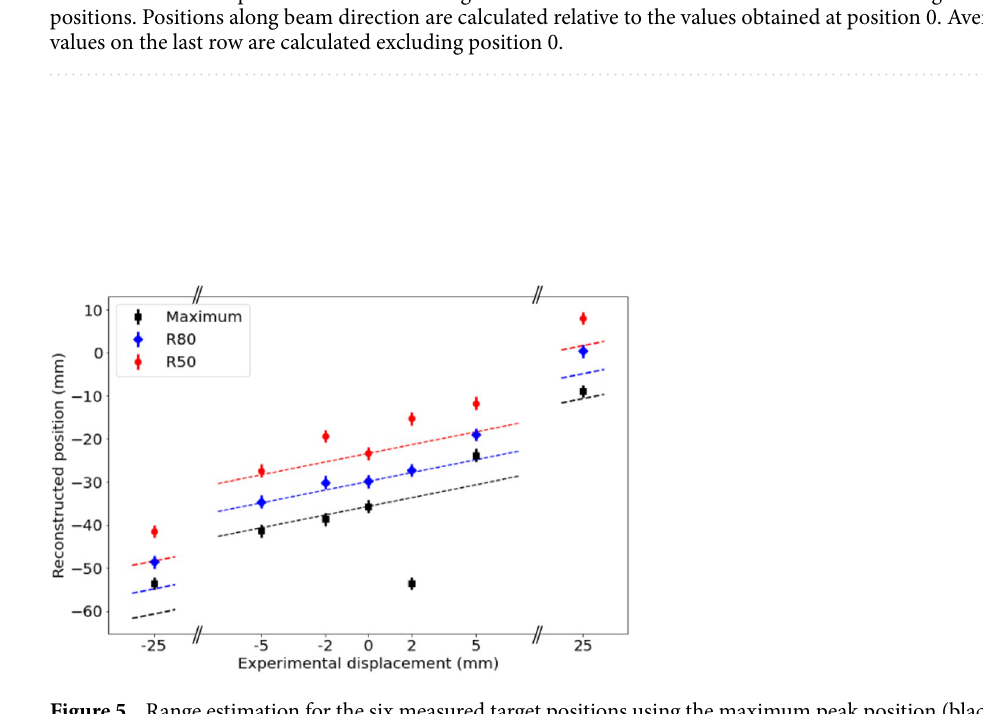
Figure 5. Range estimation for the six measured target positions using the maximum peak position (black), R80 (blue) and R50 (red) distances. Positions obtained from the longitudinal profiles at 4.4 MeV shown in Fig. 4. The error bars represent one voxel width. Dotted lines indicate the expected experimental positions, taking the values obtained from position 0 as a reference. The x axis is discontinued to include the two extreme